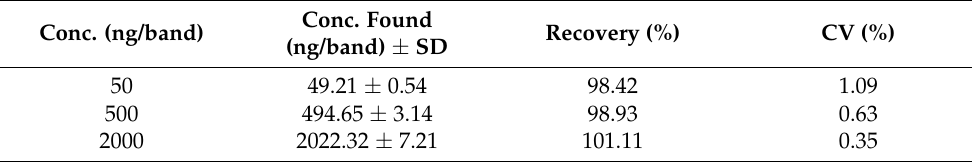
Table 2. The % thymol recoveries for the greener normal-phase HPTLC method a . Conc. Found Conc. (ng/band)